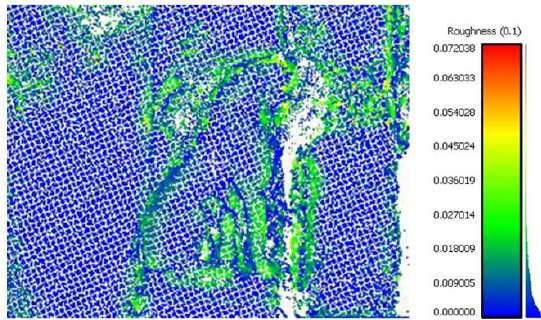
Figure 9. Roughness value. Analysis of the dataset A.